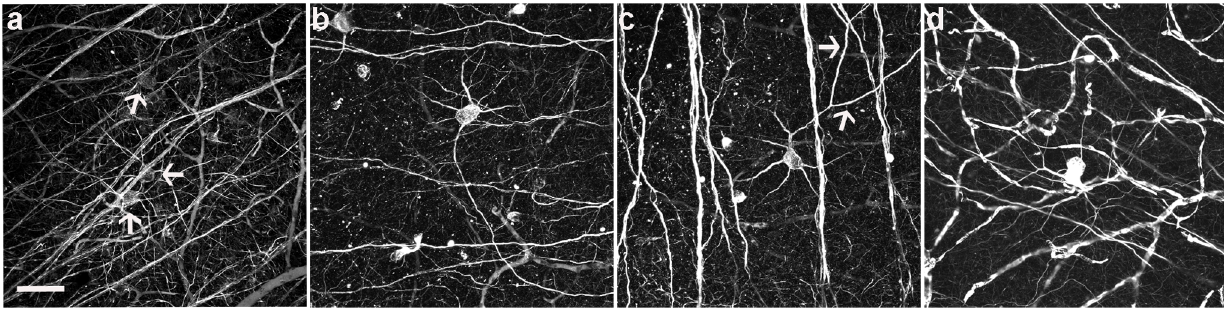
Figure 2. ON a -like ganglion cells are the most resistant type of the neurofilament-M immunoreactive cells after axotomy. (a) Control eye showing ON a -like ganglion cells (arrows) and other neurofilament-M positive ganglion cells in the peripheral area. (b, c) Examples of morphological changes (arrows in C) 21 days after axotomy in the peripheral area. (d) Example of an ON a -like ganglion cell 60 days after optic nerve transection in the peripheral area. Scale bar=50 m m.